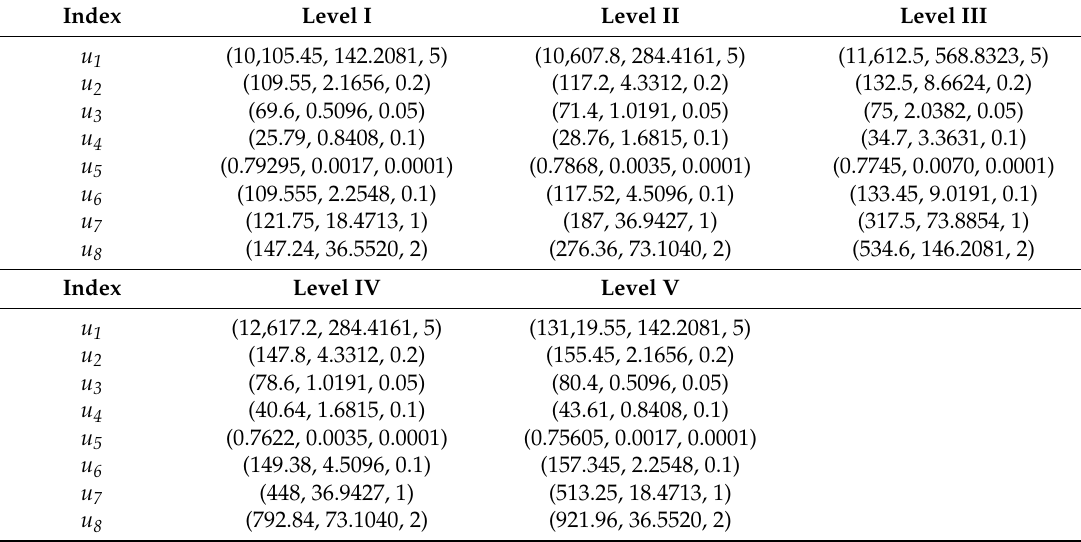
Table 12. Cloud models ( Ex , En , He ) of eight indices at different risk assessment levels.